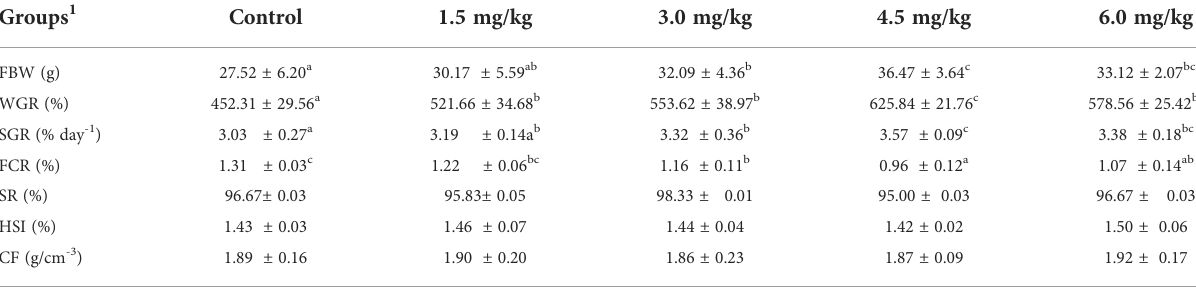
TABLE 3 Effects of PQQ on growth performance of yellow cat fi sh. Groups